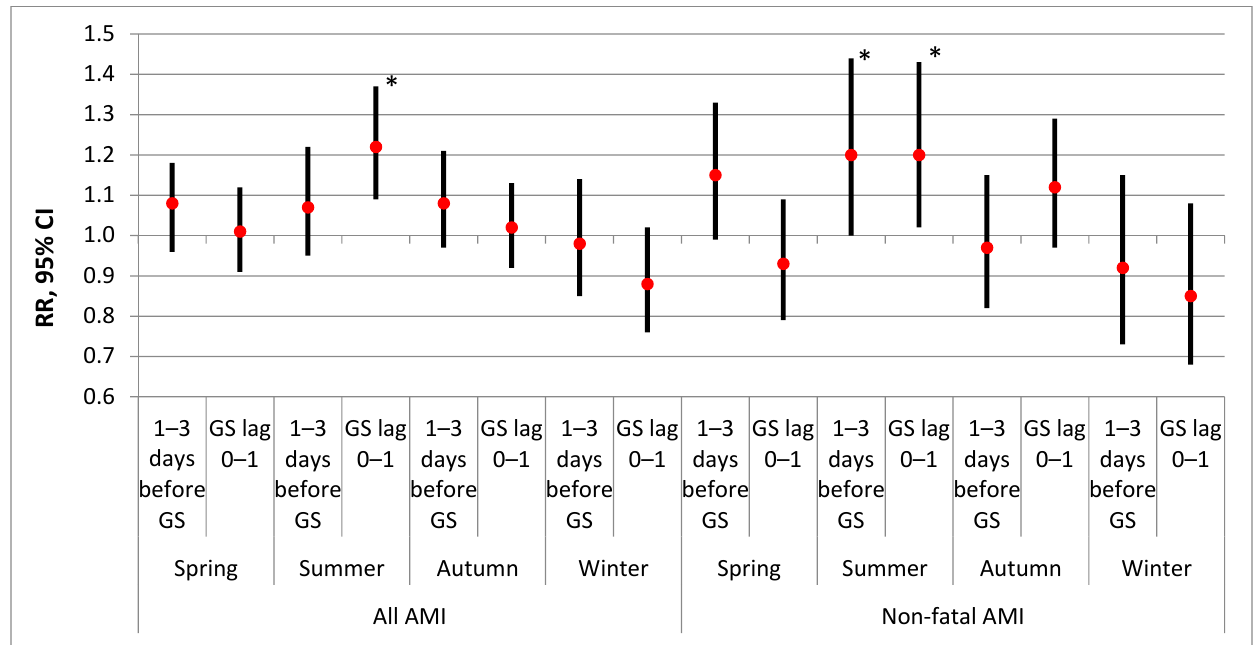
Figure 2. The effect of geomagnetic storm (the period of 3 days before GS, days of GS, and 1 day after GS) on the risk of AMI by different seasons. * p < 0.05. Table 5. The effect of geomagnetic storm (the periods of 3 days before GS, days of GS, and 1 day after GS) on the risk of AMI and death from IHD during spring–autumn by sex and age